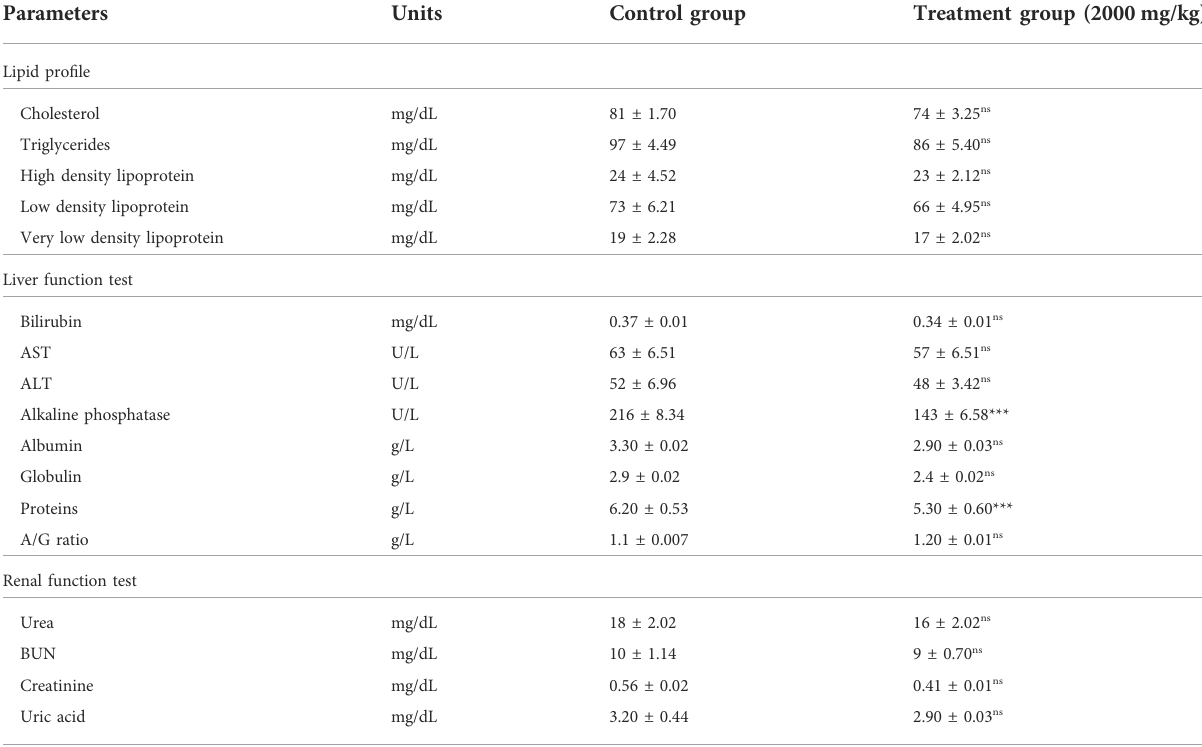
TABLE 5 Effect of ABEE (at limit dose 2000 mg/kg p.o.) on biochemical variables in an acute toxicity study.